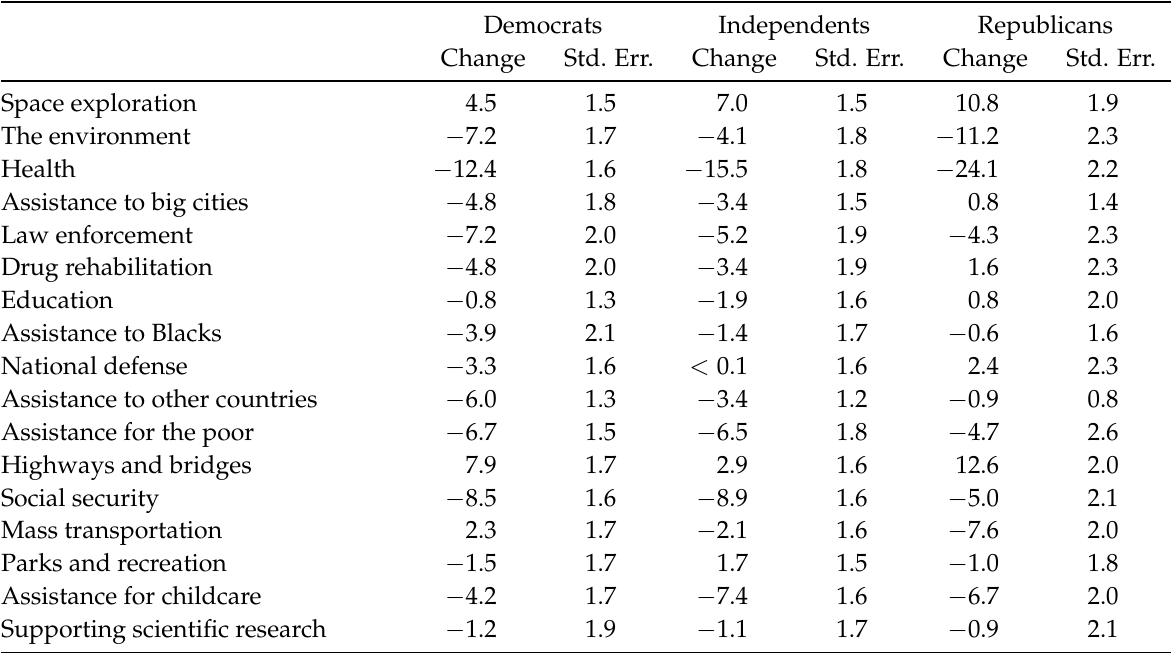
Table 2: Changes between 2004-2008 and 2010-2014 in the Percentage of Respondents who Indicate that “Too Little” Money is Spent on All GSS Spending Areas Democrats Independents Republicans Change Std. Err. Change Std. Err. Change Std.